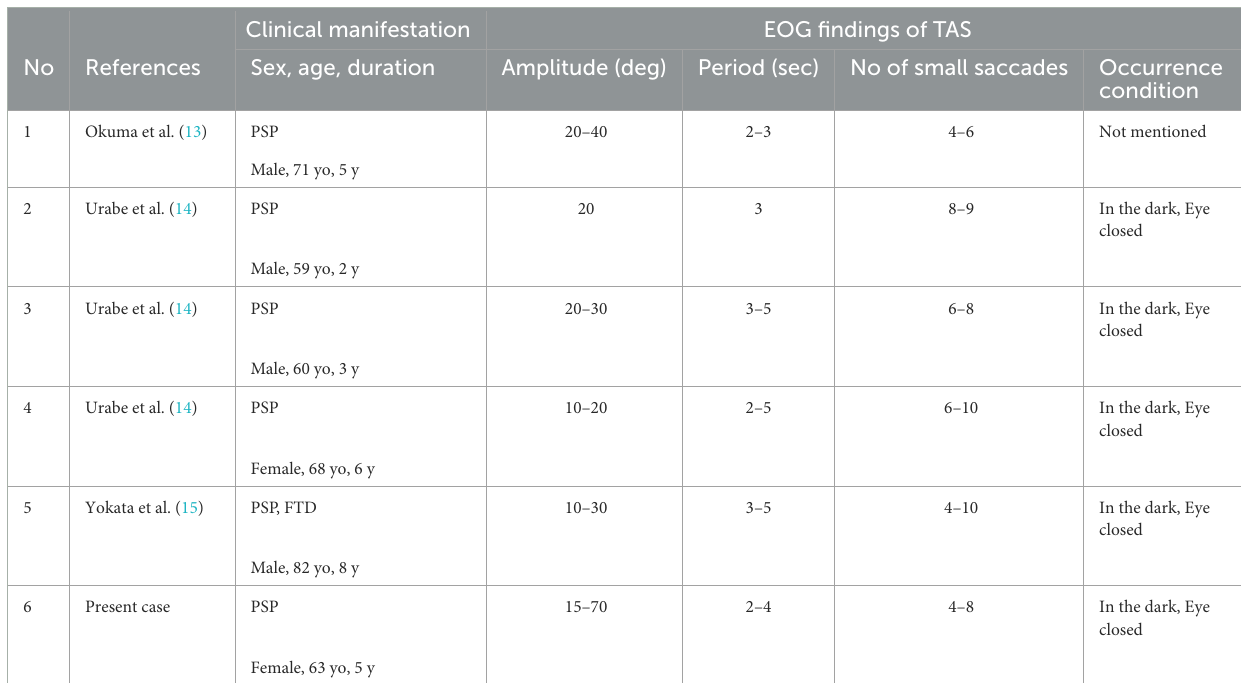
TABLE 1 Clinical manifestation and features of so-called TAS (SPPG) in